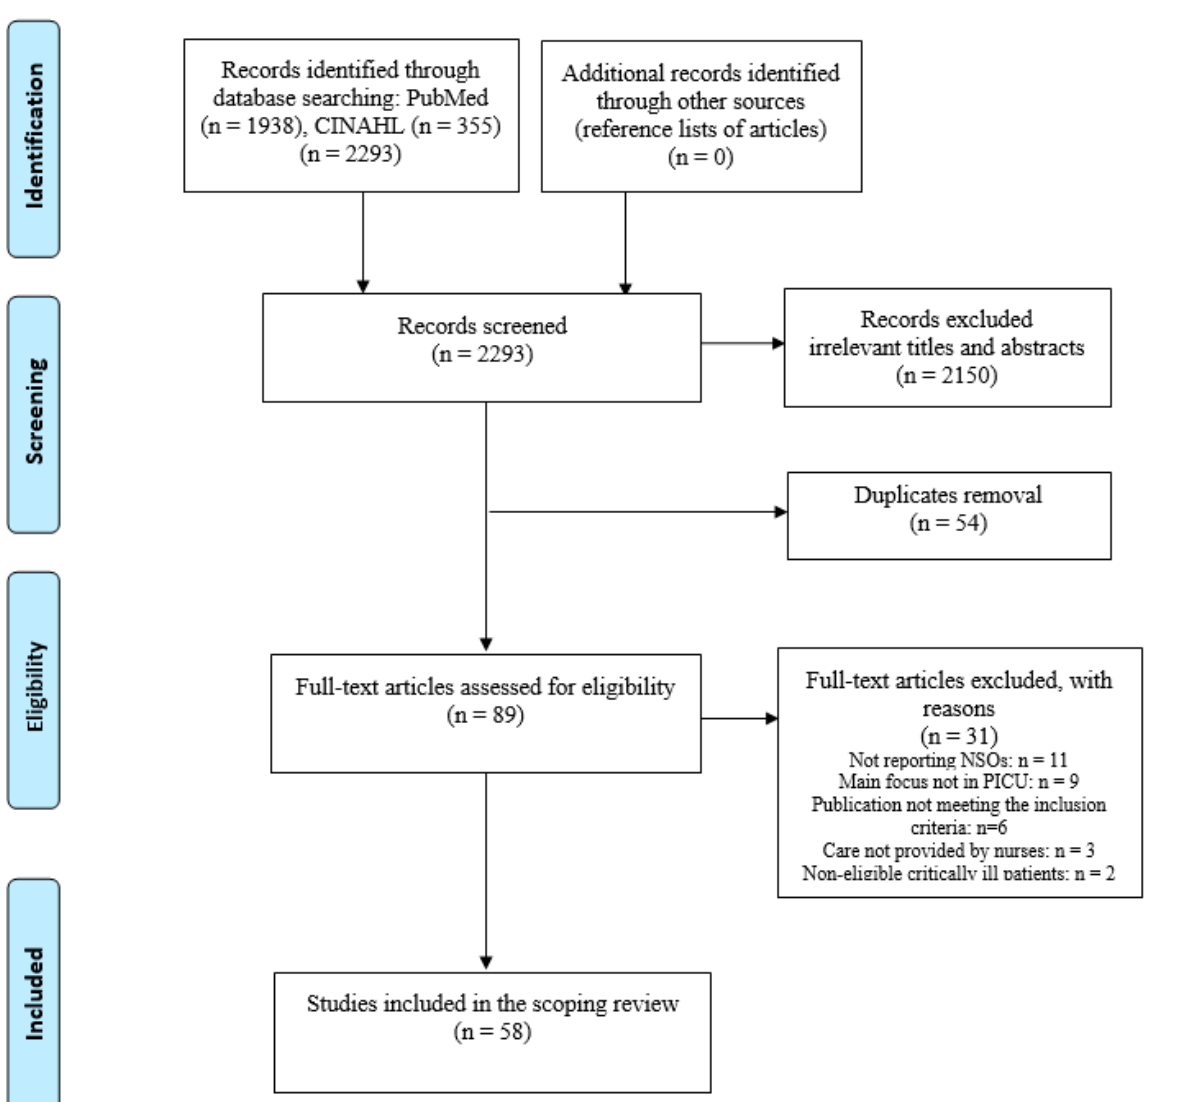
Figure 1. Preferred reporting items for systematic reviews and meta-analyses flow diagram [16]. Note: CINAHL: Cumulative Index to Nursing and Allied Health Literature; NSOs: nursing sensitive outcomes; PICU: paediatric intensive care unit.